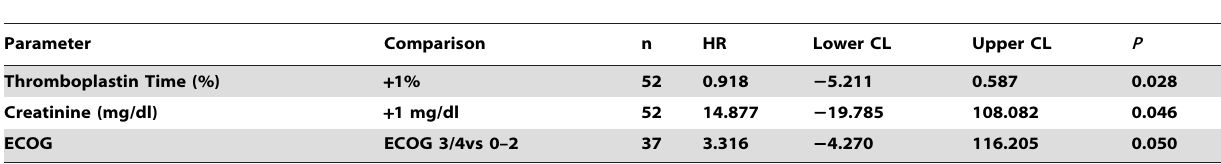
Table 6. Multivariate logistic regression for Death within 7 days (Early Death) with inclusion based on 999 bootstraps.